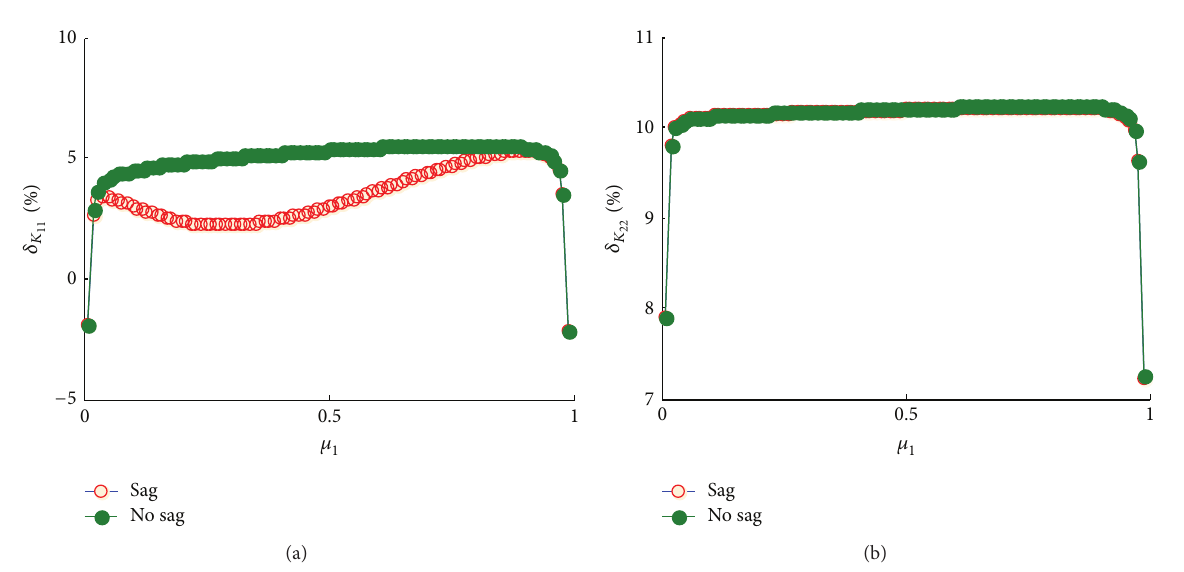
Figure 5: Relative error between main diagonal terms and the finite element